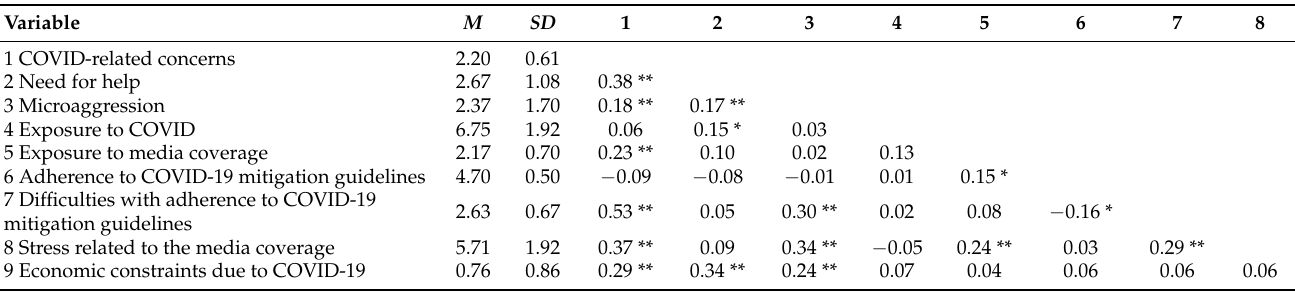
Table 2. Means, standard deviations, and correlations of the study